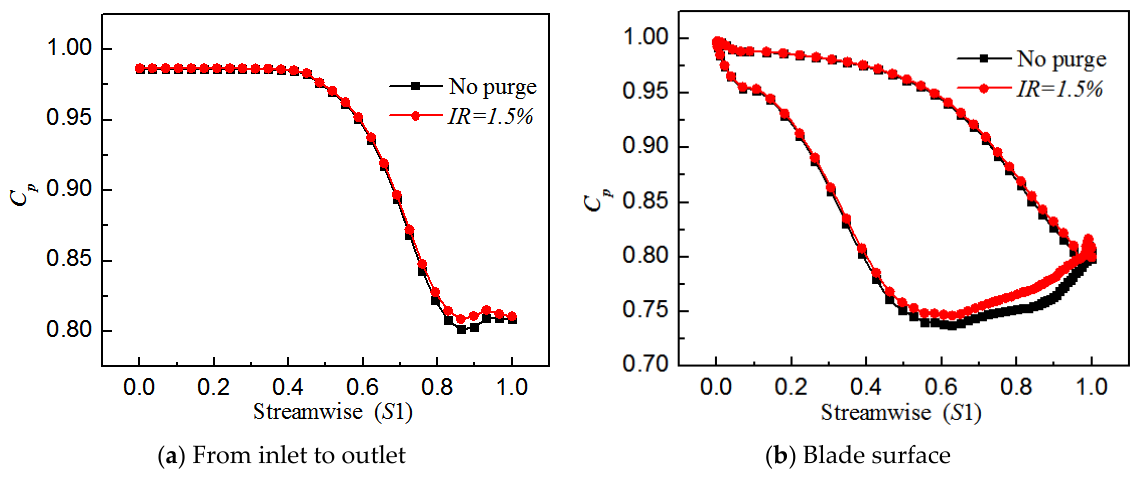
Figure 9. Time-averaged pressure coefficient distribution.